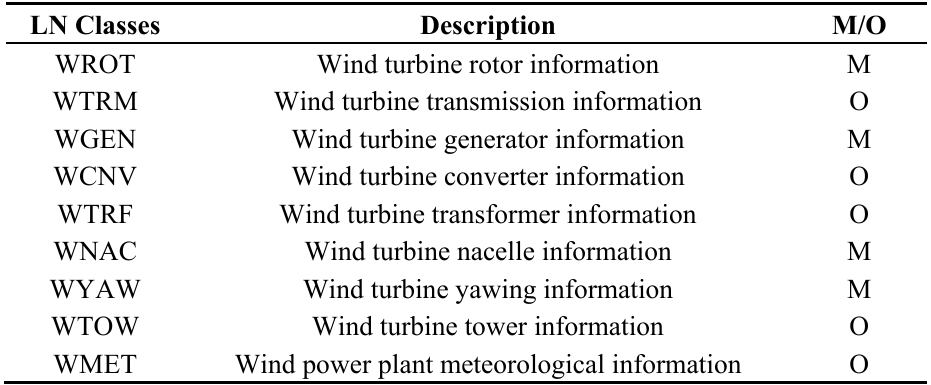
Table 1. Types of logical nodes in a wind